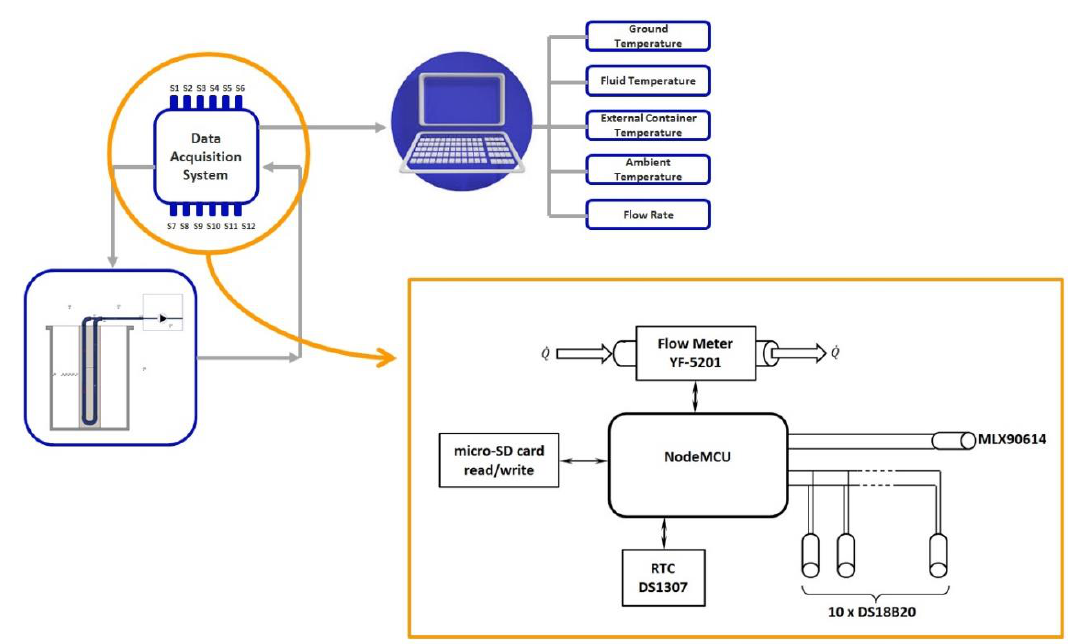
Figure 3. Schema of the data acquisition system.